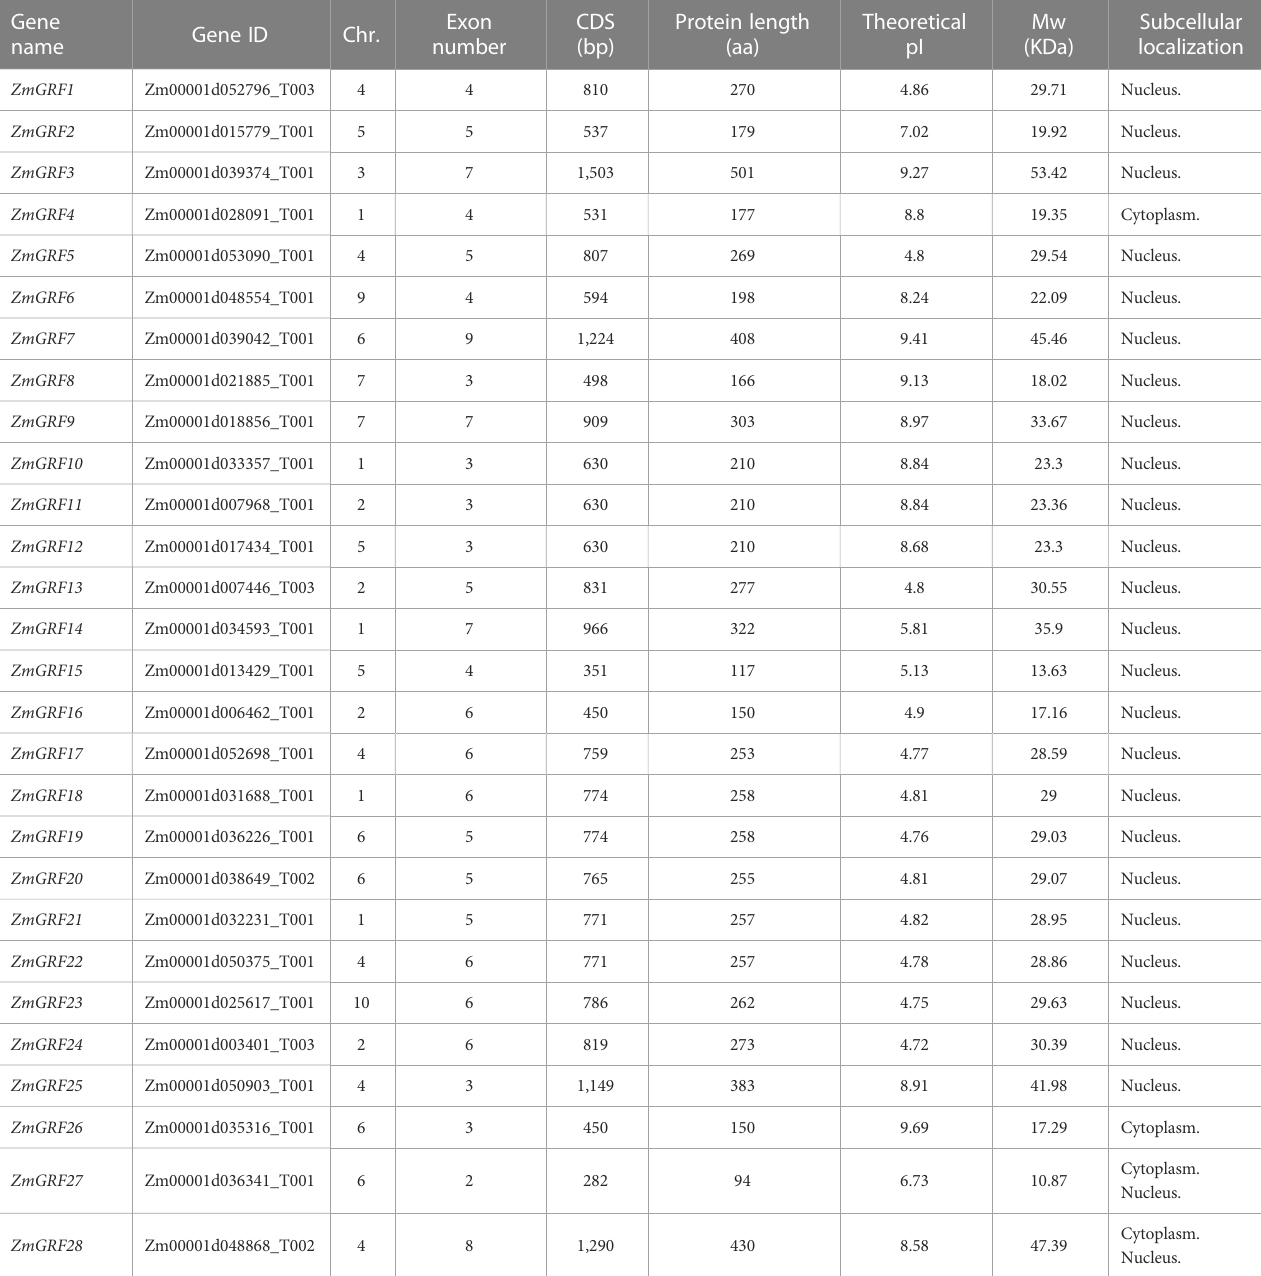
TABLE 1 Information of 14-3-3s in maize. Gene